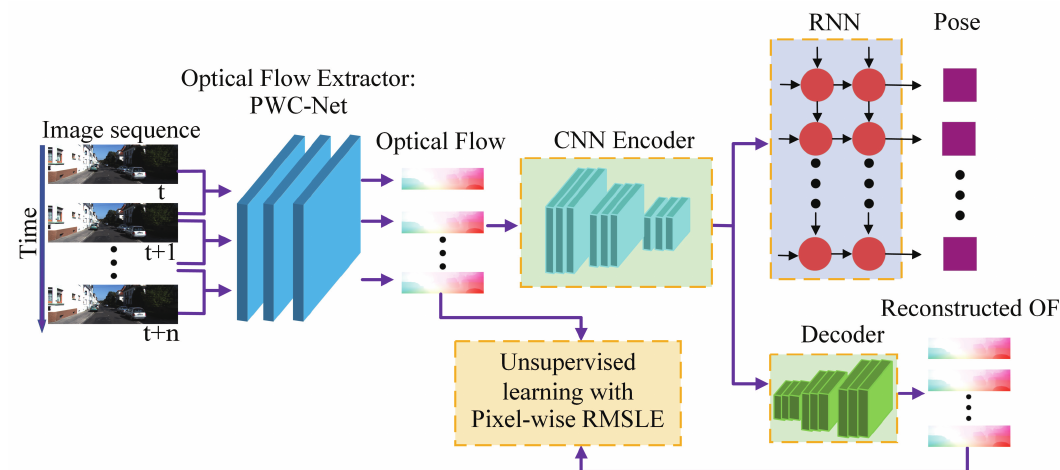
Figure 1. Framework of the method. A sequence of images is input into PWC-Net to extract optical flow (OF) field between the rolling pairs of consecutive frames. A convolutional neural network (CNN) encoder with multiple convolution layers is followed to learn the latent OF representation. An Recurrent Neural Network (RNN) is used to model sequential OF dynamics and relations between consecutive frame pairs. The sequential OF subspace extracted by the encoder is fed into the RNN to compute the regression of the 6D pose vector. The extracted OF subspace is also fed into a decoder with an inverse architecture to the encoder. The decoder reconstructs the OF field so that the encoder can be trained separately in an unsupervised manner with a pixel-wise squared Root Mean Squared Log Error (RMSLE)